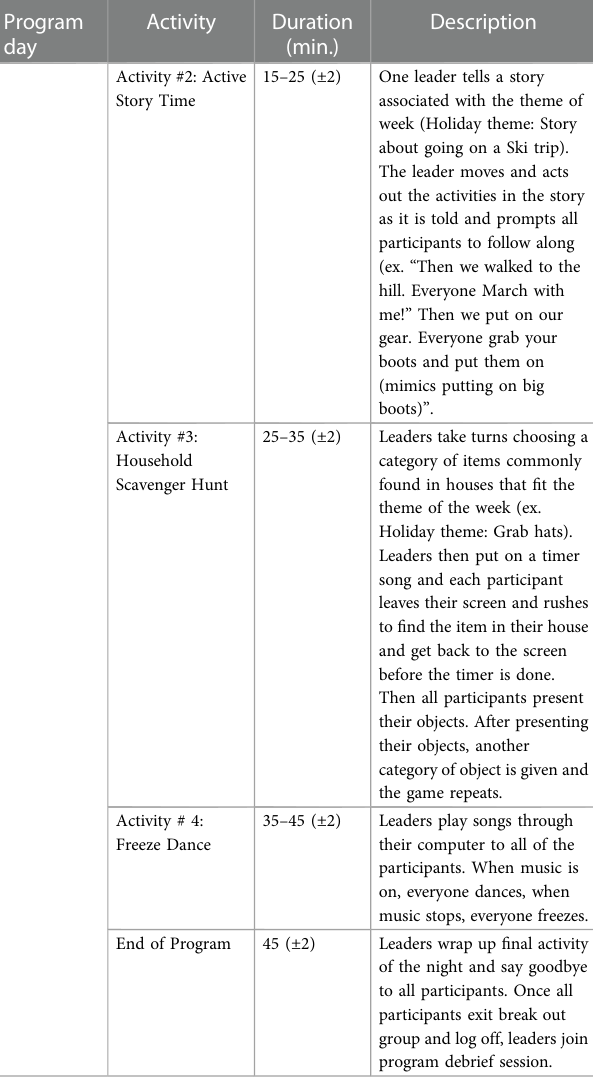
TABLE 1 Example zoom session outline for Friday and Saturday